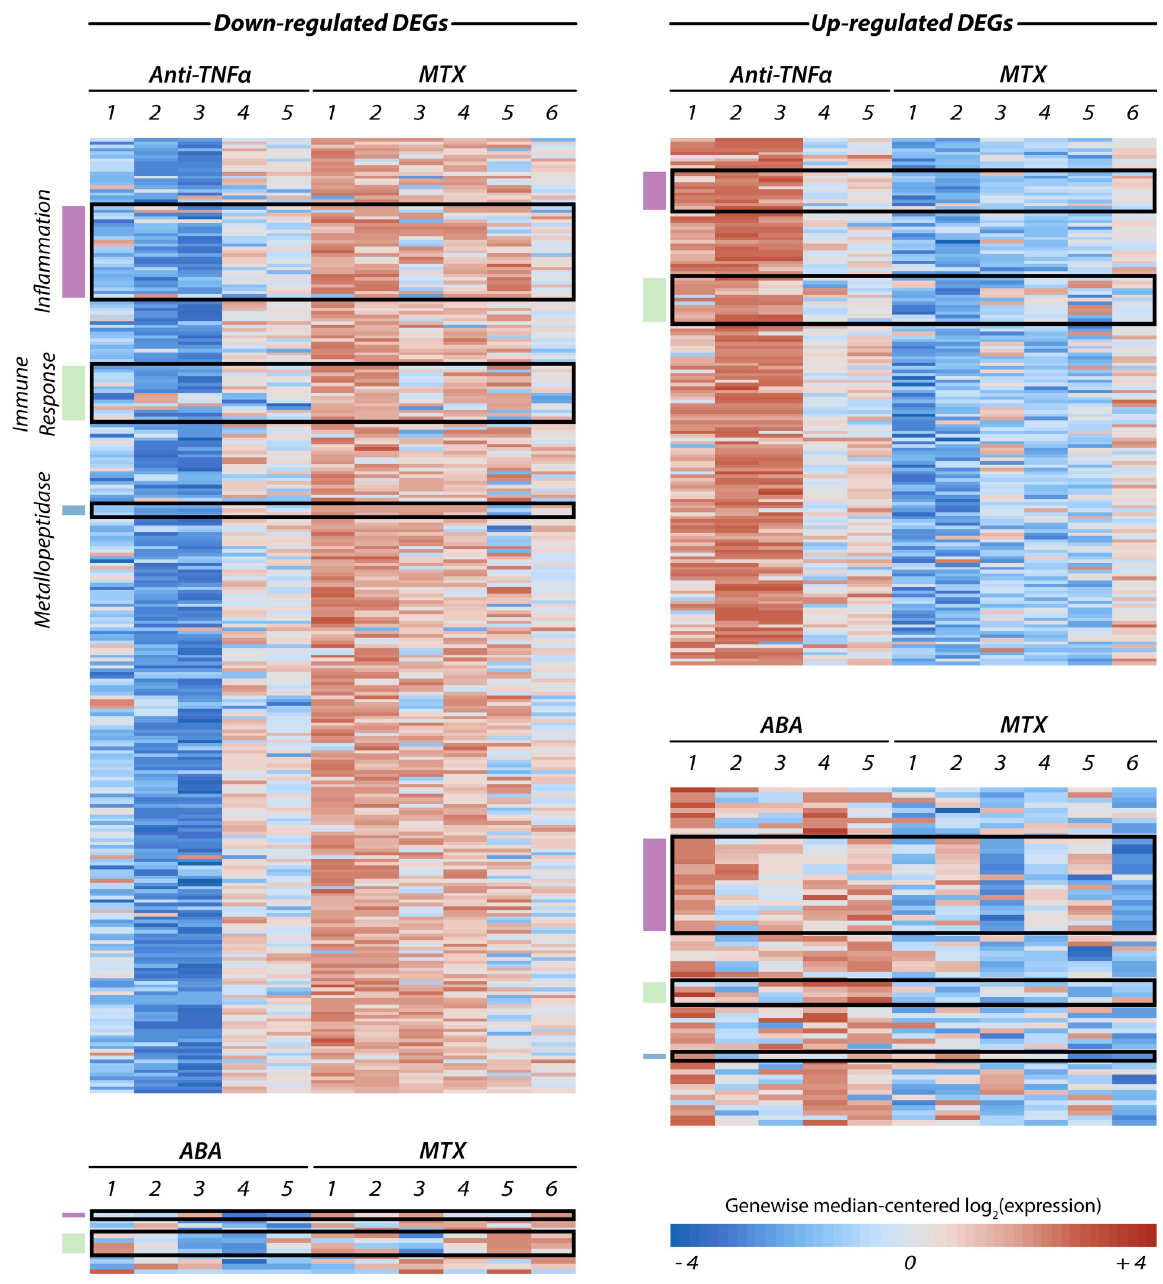
Fig 3. Heat maps showing the transcript levels of the genes significantly modified in mono-cytes isolated from abatacept- (ABA), anti- TNF α -, and MTX-treated RA patients. Each row represents the (log 2 ) expression profile of a different DEG centred around its median value, while columns are individual patients. Some relevant functional gene sets are annotated to the left of each map using the following colour scheme: purple for inflammation, green for immune response, and blue for metallopeptidases. The complete list of genes in these categories can be found in S1 File, where the same colour conventions are